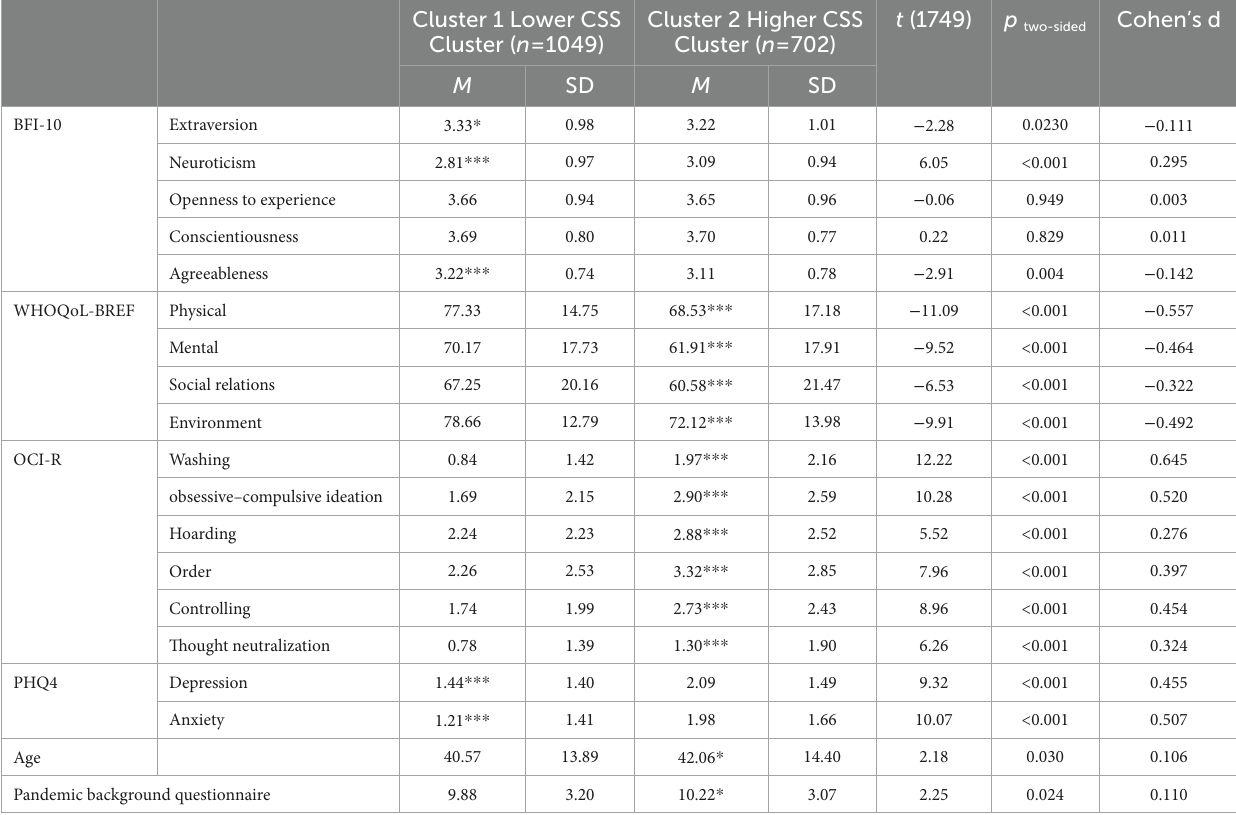
TABLE 3 Means and standard deviations of the BFI-10, WHOQoL, OCI-R, and PHQ-4, age, and Pandemic background questionnaire, divided by cluster classification.